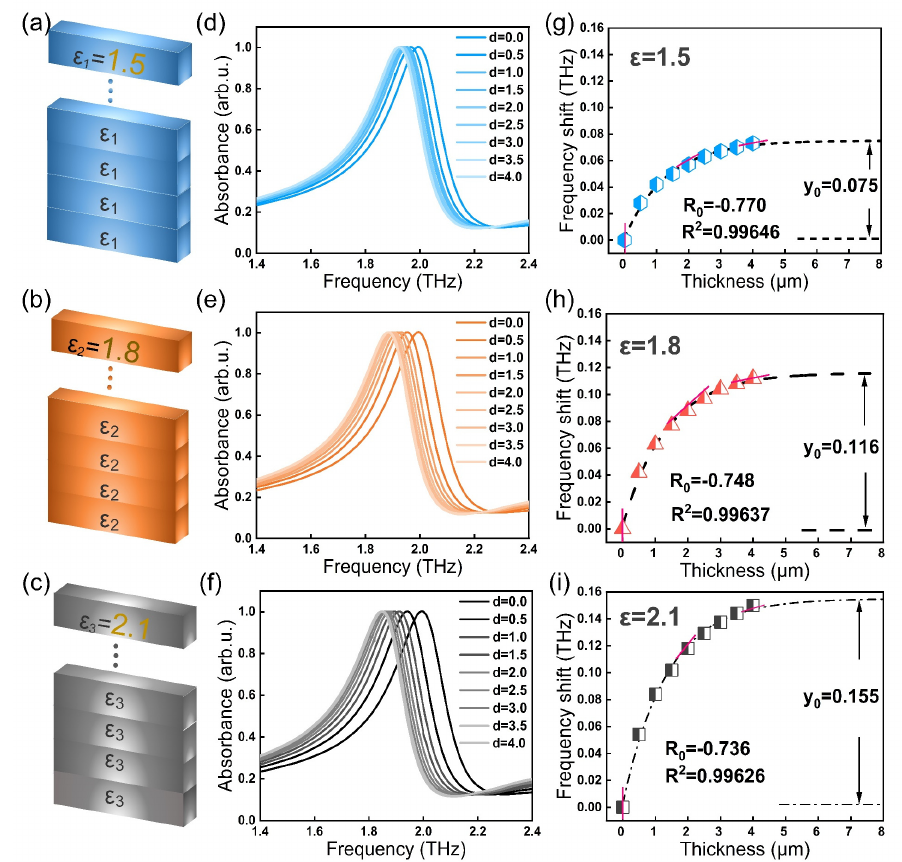
Figure 3. Theoretical calculation of THz SPR biosensor for materials with different dielectric constants. ( a – c ) Schematic diagram of calculation model. ( d – f ) Theoretical results of different dielectric constant samples for THz SPR biosensors. ( g – i ) Corresponding frequency shift as a function of different sample thickness.